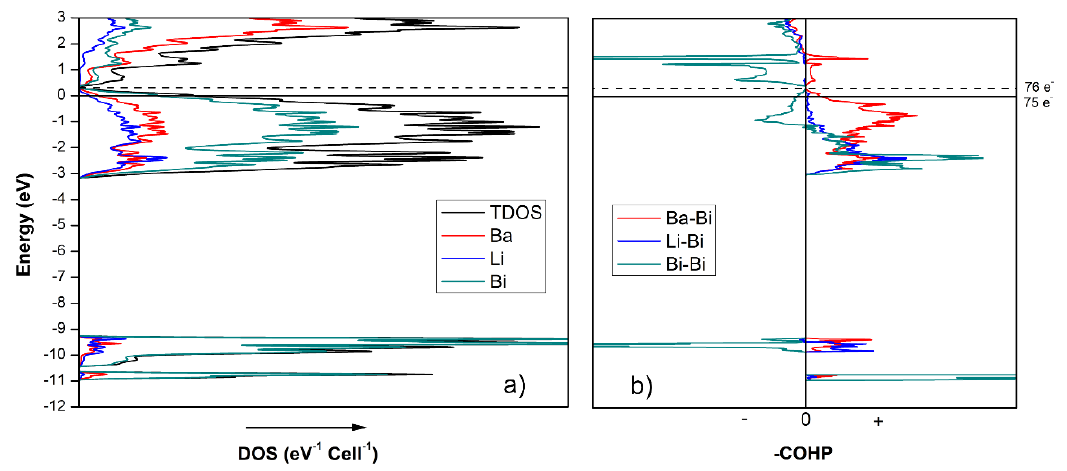
Figure 6. ( a ) Projected total and partial DOS for Ba 7 Li 11 Bi 10 . The partial DOS curves illustrate the contribution of different atoms to the total DOS ( E F = 0 eV). ( b ) The reversed COHP plots for Ba–Bi, Li–Bi and Bi–Bi interactions shown on the same energy scale.